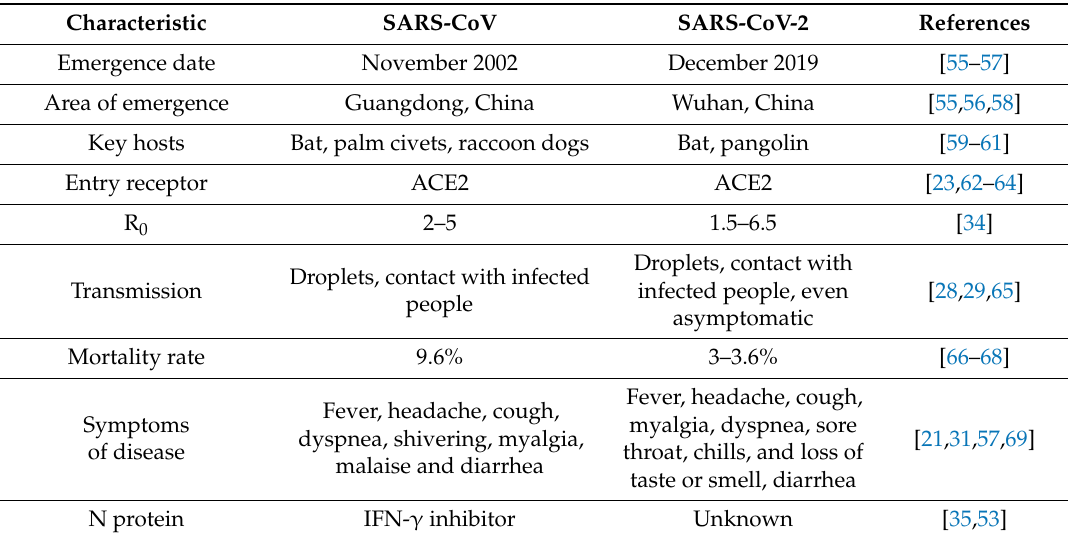
Table 1. Comparison of the biological features of SARS-CoV and